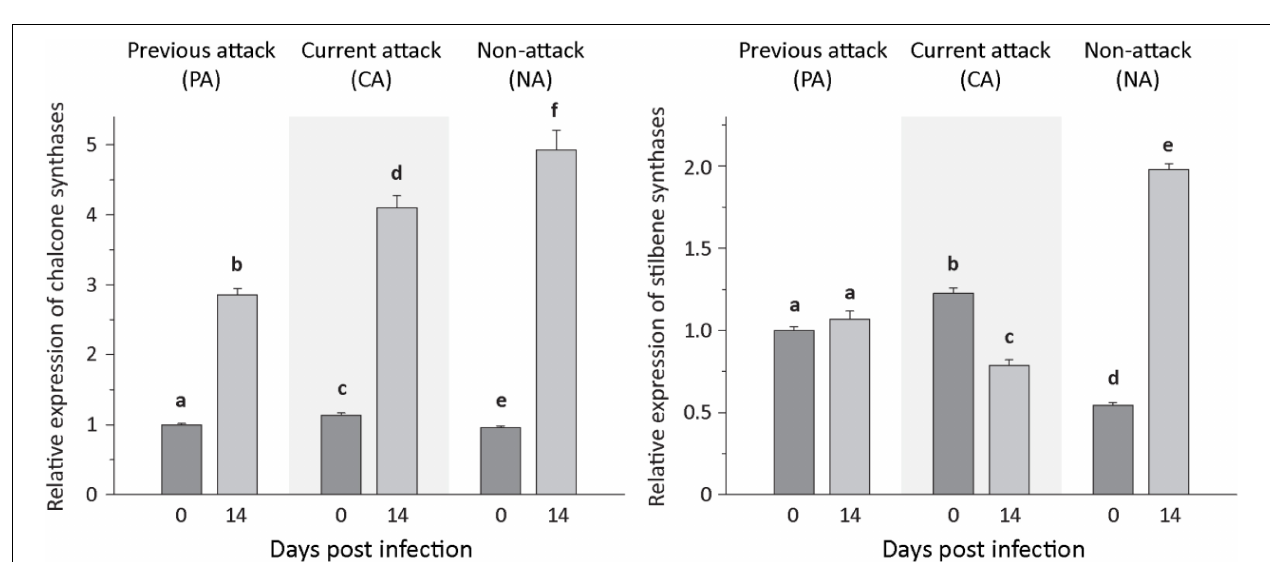
FIGURE 5 | Relative expression of phenolic biosynthetic genes before and after Endoconidiophora polonica infection. The relative expression of chalcone synthases (left panel) and stilbene synthases (right panel) were measured by quantitative real-time PCR analysis from bark tissue harvested before and 14 days after infection with E. polonica . Trees investigated: (1) were from a stand with a history of previous bark beetle attack, but no current attack (PA), (2) were under current attack, but had no previous history of attack (CA), or (3) had no previous nor current attack (NA). Different letters indicate significant differences. Data are means ± SD of measurements from 6 to 12 biological replicates; exact numbers are given in the Section “Materials and Methods.” Statistical values for individual compounds are given in Supplementary Table 6